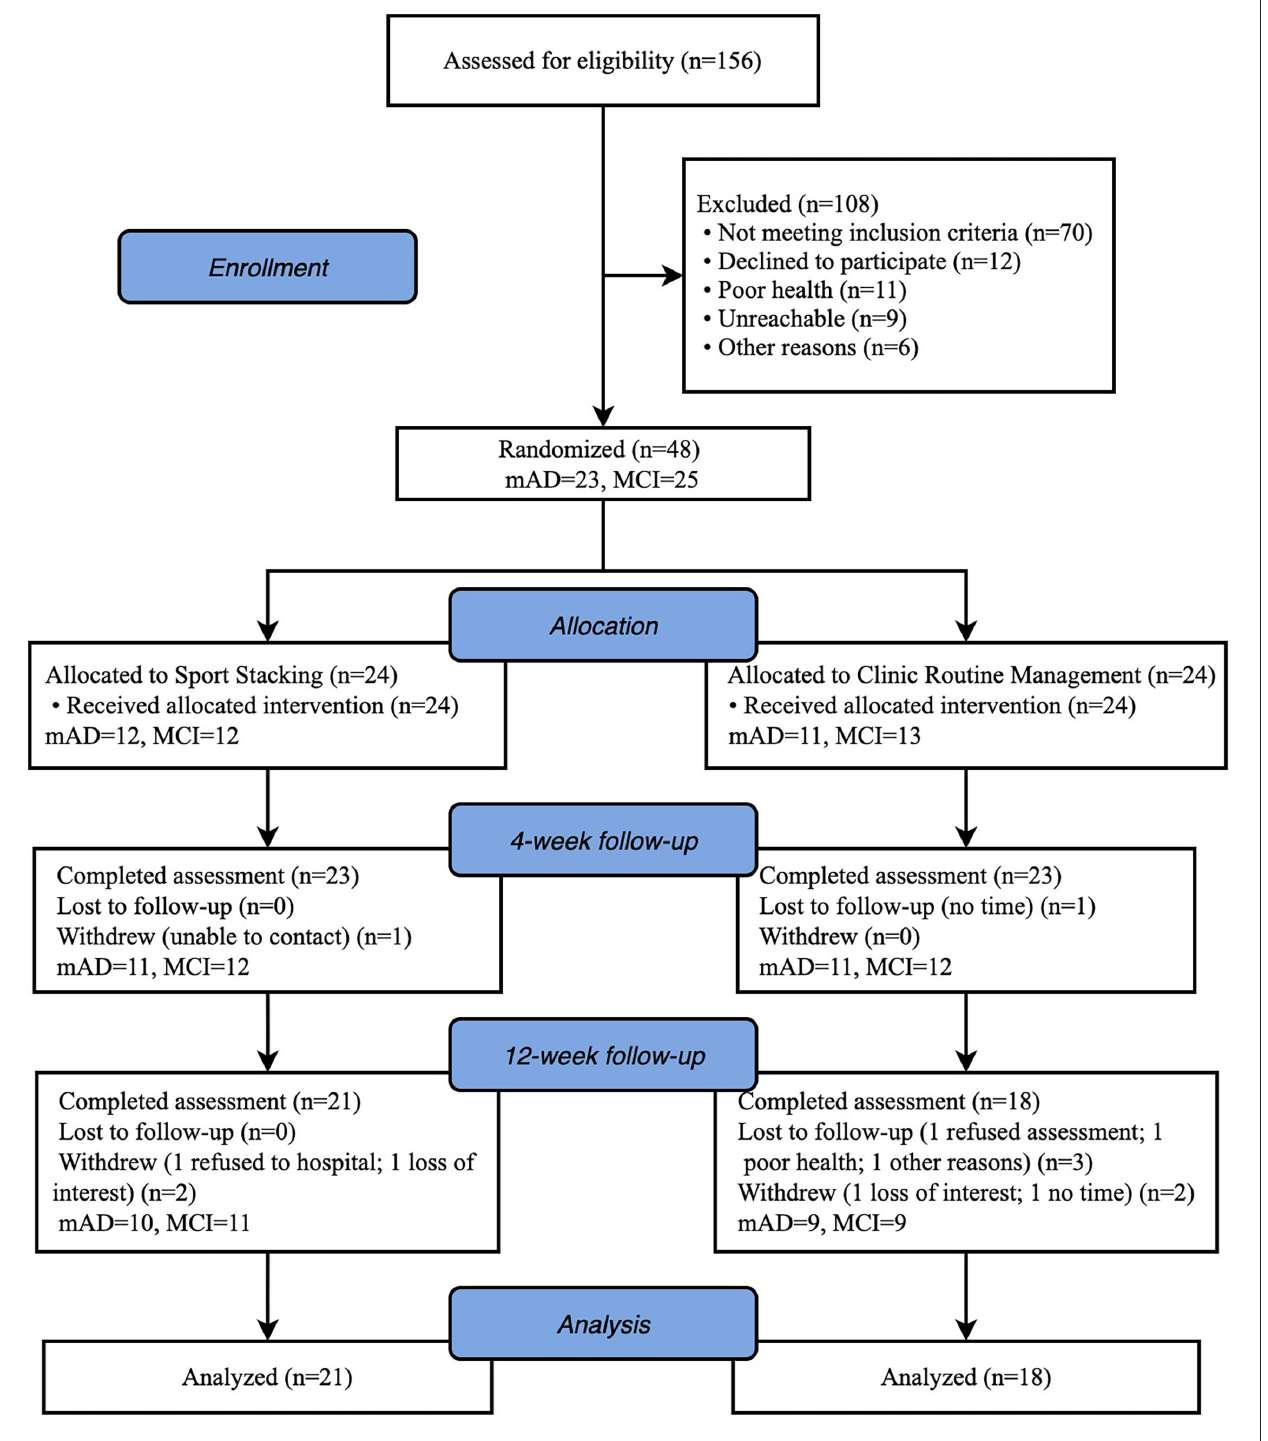
FIGURE 2 | Study flow